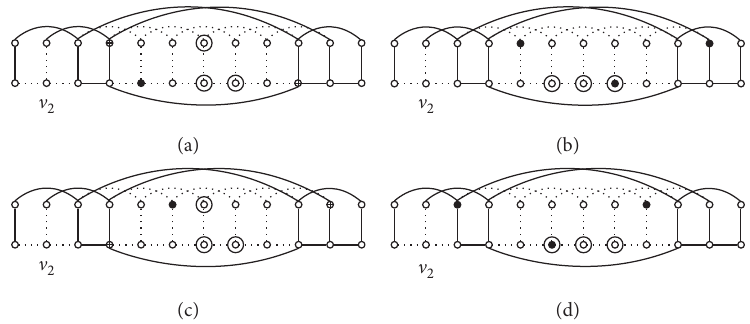
Figure 4: The four possible cases of S in Subcase 6.